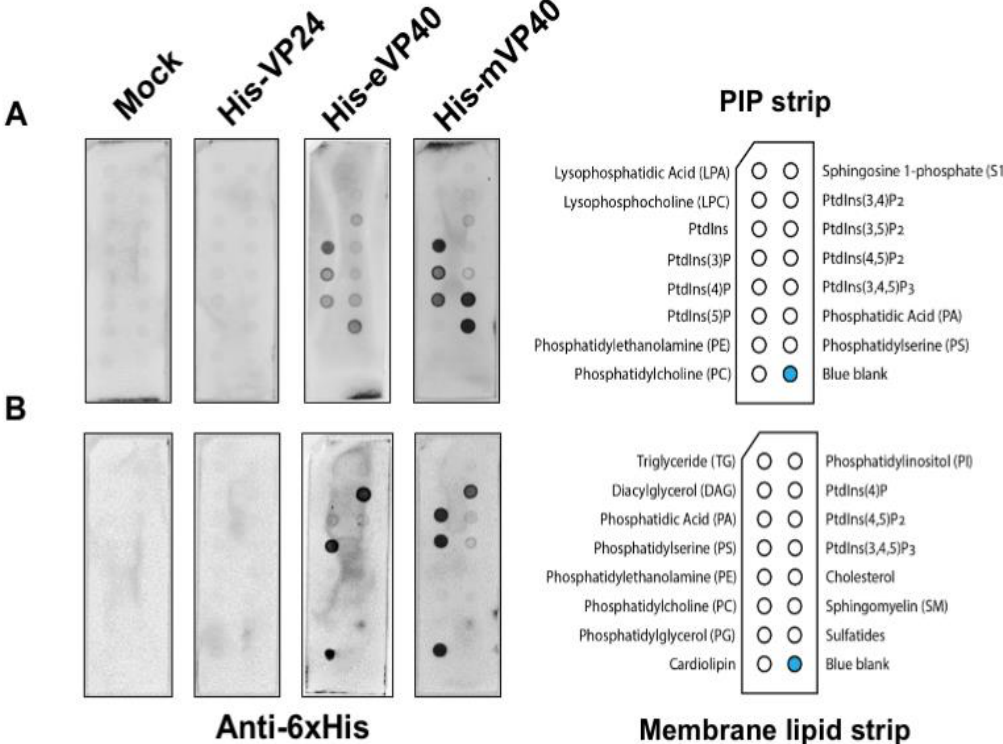
Figure 1. Ebola virus VP24 does not bind to lipids by lipid overlay assay. In this assay, 1 μg/mL of purified recombinant His-VP24, His-eVP40 and His-mVP40 proteins were incubated with PIP lipid strip ( A ) and membrane lipid strip ( B ) overnight at 4 °C. The protein purified from E. coli transformed with the empty protein expressing vector was used as the mock control. eVP40 and mVP40 bound to certain anionic lipids as expected while VP24 did not bind to any lipid tested.